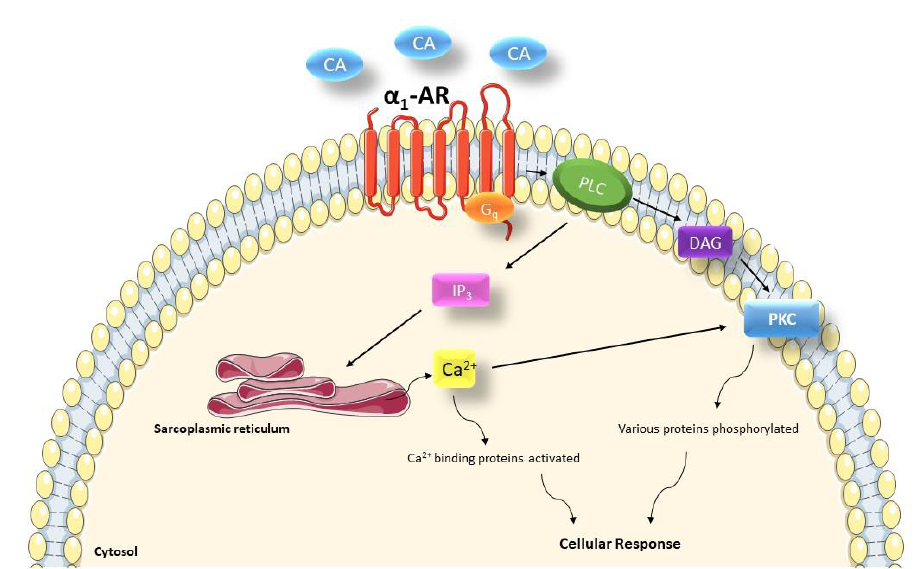
Figure 2. The prototypical signaling pathway of α 1 -ARs. CA: catecholamines, DAG: diacylglycerol, IP3: inositol triphosphate, PKC: protein kinase C, PLC: phospholipase